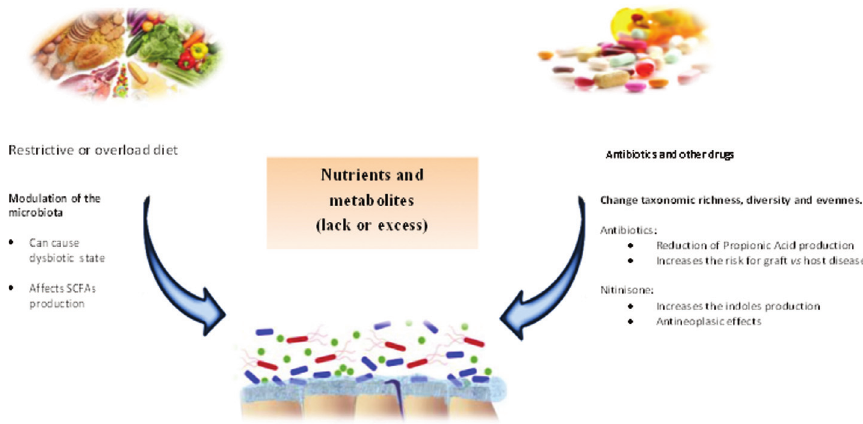
Figure 2 - Common treatments used in IEM and its effects over the microbiome. Diet is an important modulator of the microbiome, and also is a very common treatment for several IEMs. Diets with restriction or abundance of certain nutrients can cause a dysbiotic state, leading to an abnormal immune signaling (inflammation), leaking of gut-blood barrier, and breaking of the energetic balance of cells, with potential to affect the whole body. Antibiotics, on other hand, cause rapid and significant drops in taxonomic richness, diversity and evenness. This can bring benefits, as in the case of propio- nic/methylmalonic acidemia patients, by decreasing the levels of propionic/methylmalonic acid, or not, as in the case of organ transplants, once patients treated with antibiotics during the perioperative period had an increased risk for graft vs. host disease. Organ transplantation is a treatment for